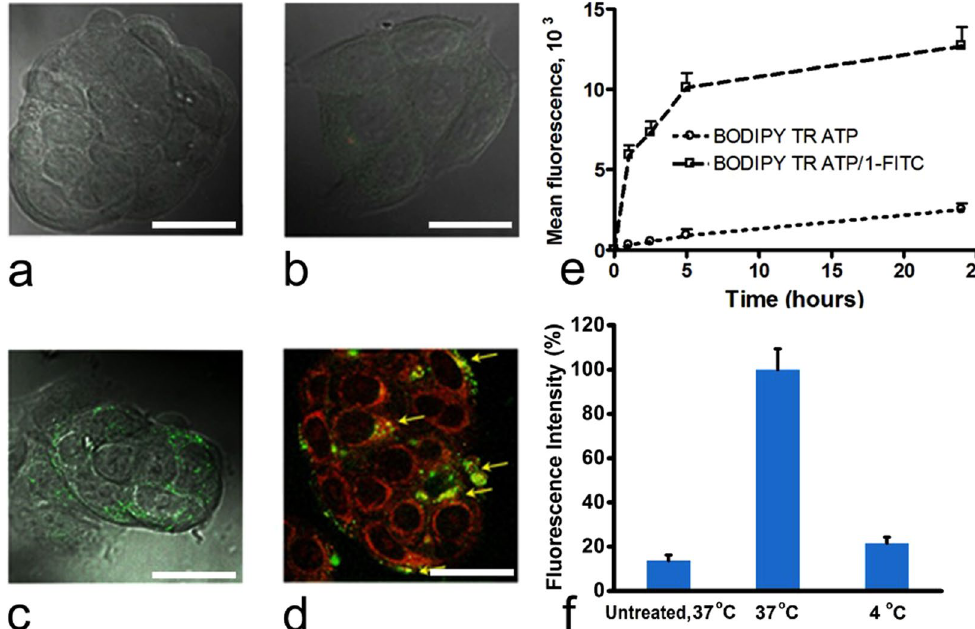
Figure 5. Confocal microscopy images of MCF7 cancer cells incubated 24 h at 37 °C ( a ) without treatment, merged image of contrast phase with green fluorescence ( b ) BODIPY ® TR ATP alone, merged image of contrast phase with red fluorescence, 1-FITC alone, merged image of contrast phase with green fluorescence ( d ) BODIPY ® TR ATP /1-FITC complex, merged image of red and green fluorescence: arrows indicate yellow spots of clear red and green fluorescence co-localization. Scale bar = 20 microns. Kinetics of cellular uptake of BODIPY ® TR ATP encapsulated (or not) in CDs in MCF7 cells ( e ). ( f ) Energy-dependent internalization of BODIPY ® TR ATP /1-FITC complex in MCF7 cells (mean fluorescence ± SD). Cells were treated with 1 µ M of BODIPY ® TR ATP/ 1-FITC complex at either 37 °C or 4 °C or untreated (negative control). Results were normalized with respect to the data obtained at 37